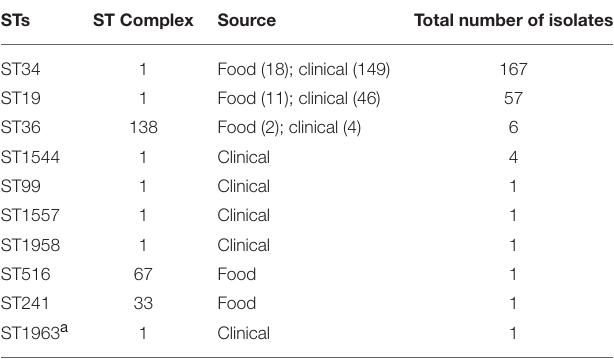
TABLE 2 | MLST sequence types (STs) of 240 S. Typhimurium